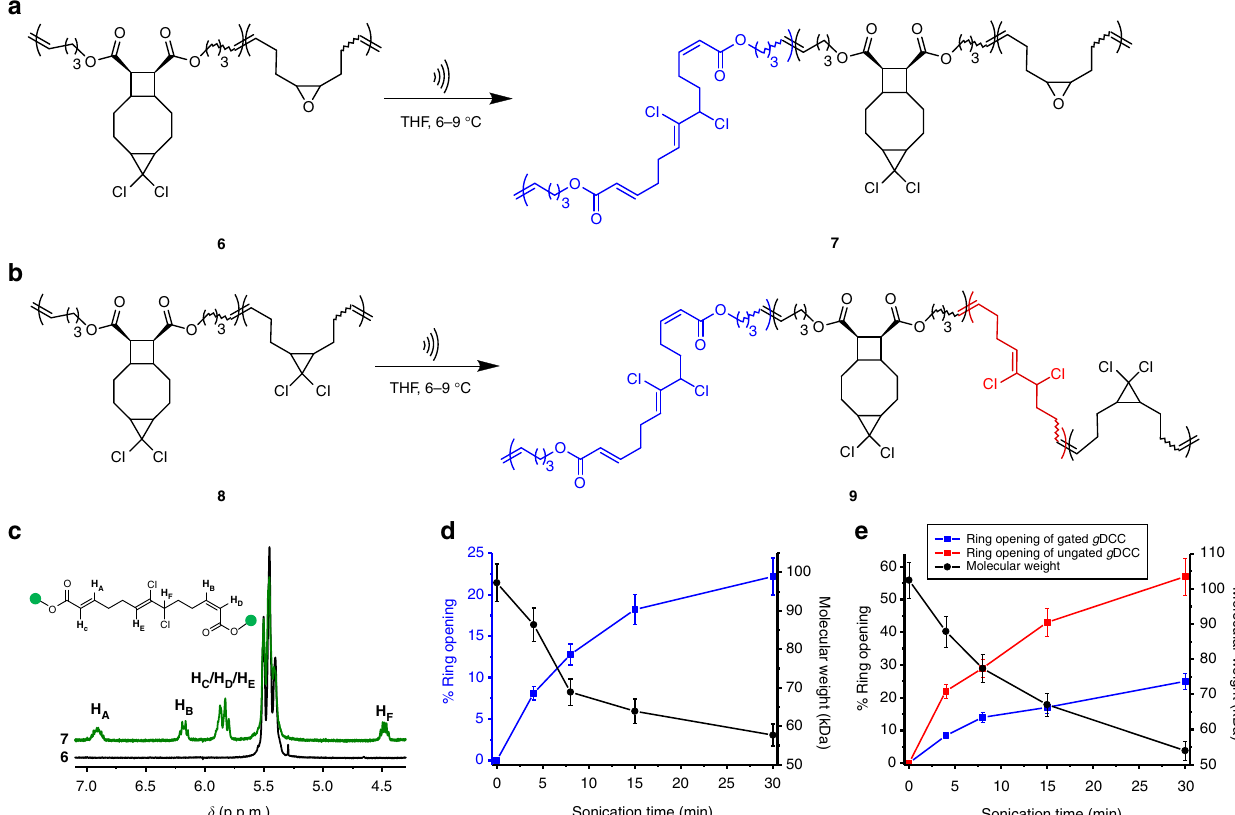
Figure 5 | Sonication of copolymers of DCTCU with epoxide (6) and cis - g DCC (8). ( a , b ) Primary chemical reactions resulting from sonication of 6 ( a ) and 8 ( b ). Sonication of 8 leads to ring opening of g DCC gated within the initial DCTCU (blue fragment in 9) and ungated along the polymer backbone (red fragment). ( c ) Partial 1 H NMR spectrum of polymer 6 before (black) and after (green) sonication. ( d , e ) Molar fractions of isomerized DCTCU moieties (blue, polymers 6 and 8 ) and backbone g DCC moieties (red, polymer 8 only) as a function of sonication time of polymer 6 ( d ) and 8 ( e ). As is typical for every other polymer reported, non-selective backbone fragmentation competes with mechanophore-centered chemistry during sonication of polymers 6 and 8 , decreasing their average molecular weights (black axes and Supplementary Figs 8 and 9). Error bars are standard